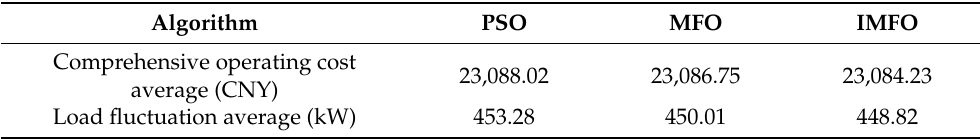
Figure 11. Comparing the results of 100 runs of different algorithms. Table 3. Average of 100 runs of different algorithms. Table 3. Average of 100 runs of different